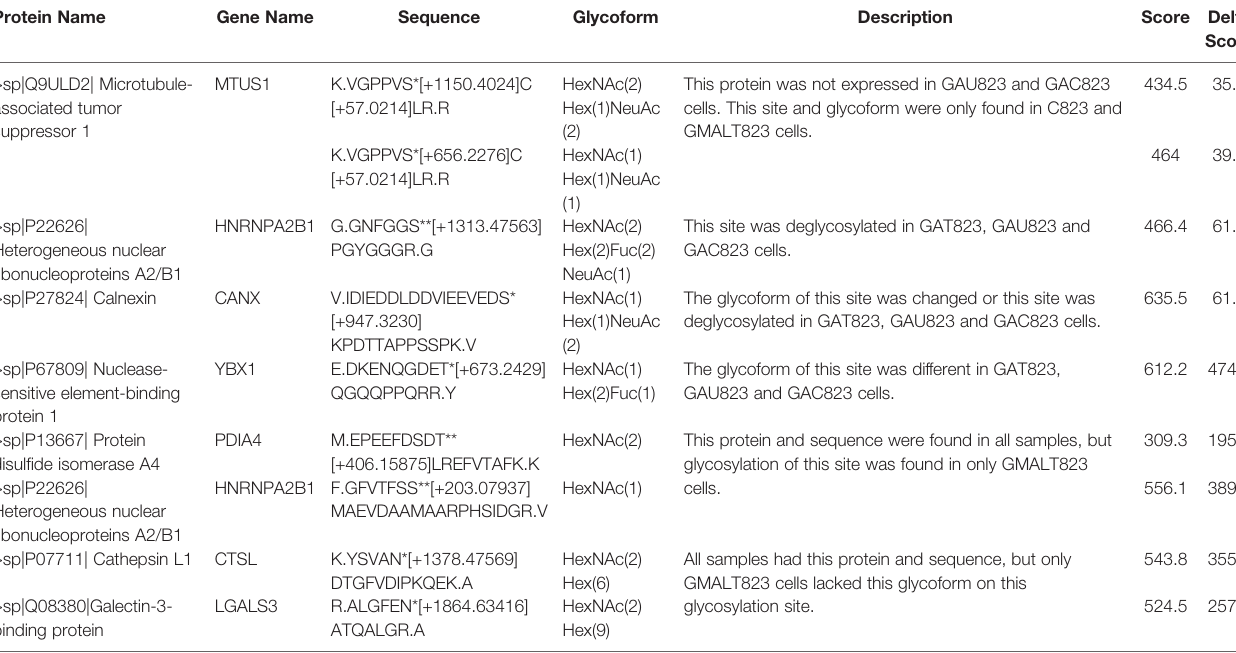
TABLE 2 | Summary of speci fi c glycosylation modi fi cations in the BCG823 cell line infected with MALT lymphoma-related H. pylori